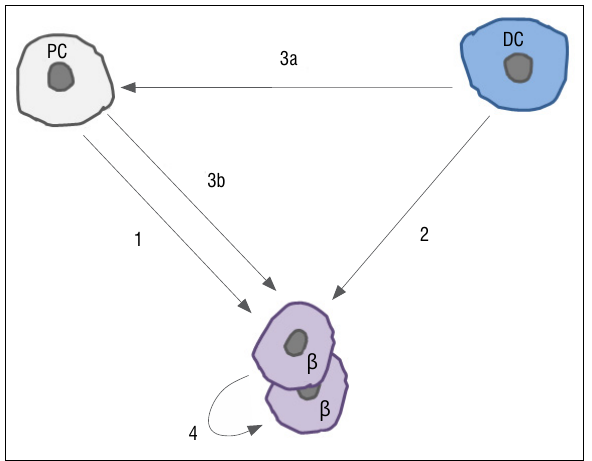
Proposed mechanisms of β -cell regeneration. β -Cells ( β )